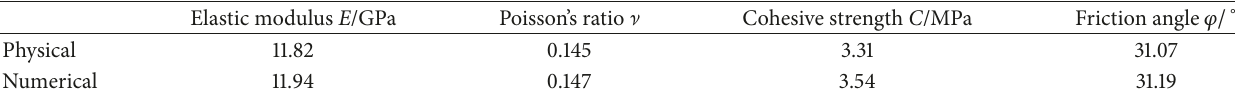
Figure 8: Numerical model of the direct shear test (blue: particles; white: parallel bonds; green: smooth joint model). Table 2: Calibration results of the macroscale parameters of intact samples.